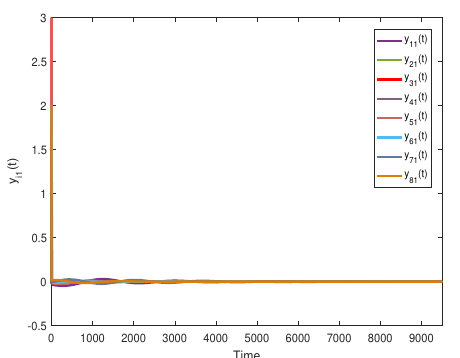
Figure 11. The trajectories of y i 1 ( t )